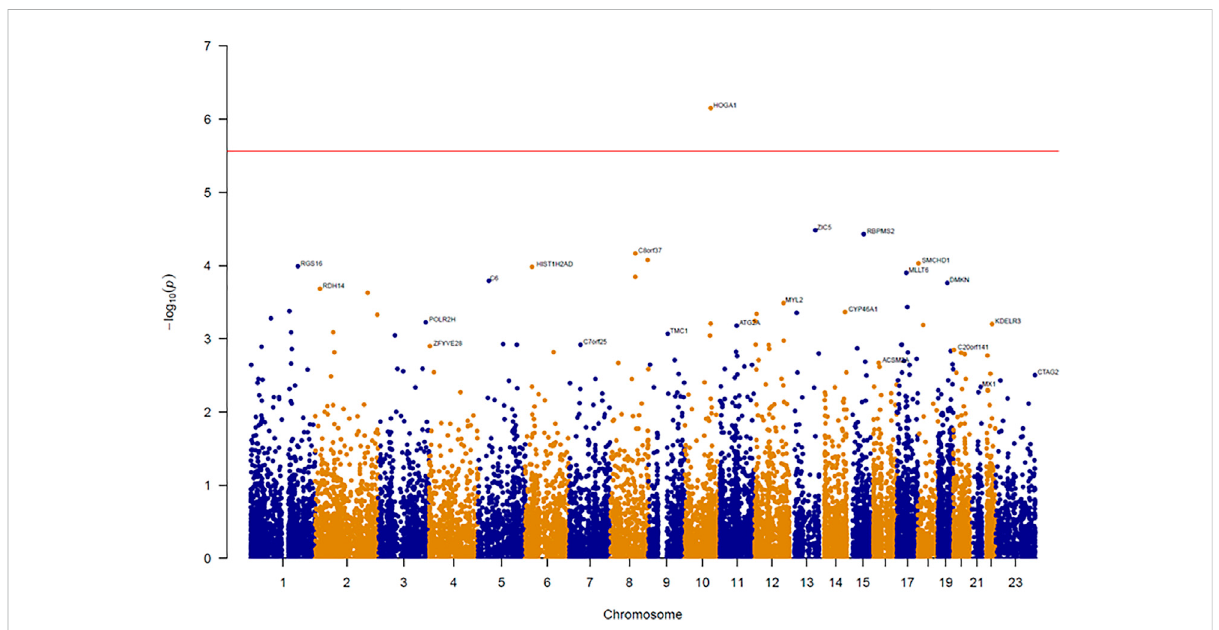
FIGURE 1 Manhattan plotofresults fromgene-basedassociationanalysisforBMI.The negativelogarithmoftheassociation p -value forgenesdistributed in the autosomal genome is represented as a dot. The red line represents the exome-wide signi fi cant p -value ( p -value < 2.7 × 10 – 6